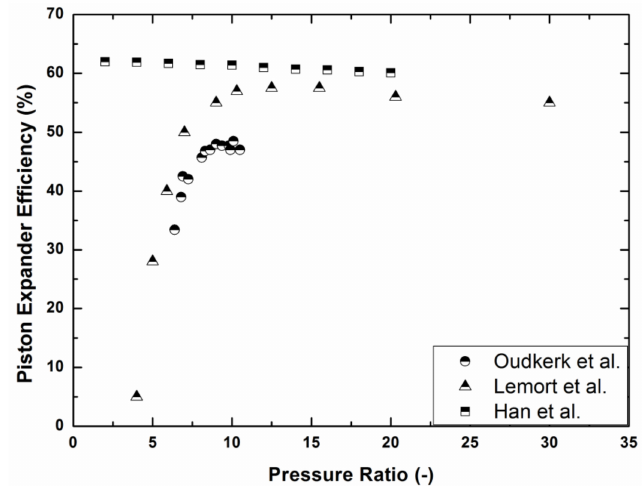
Figure 7. Performance of piston expander.